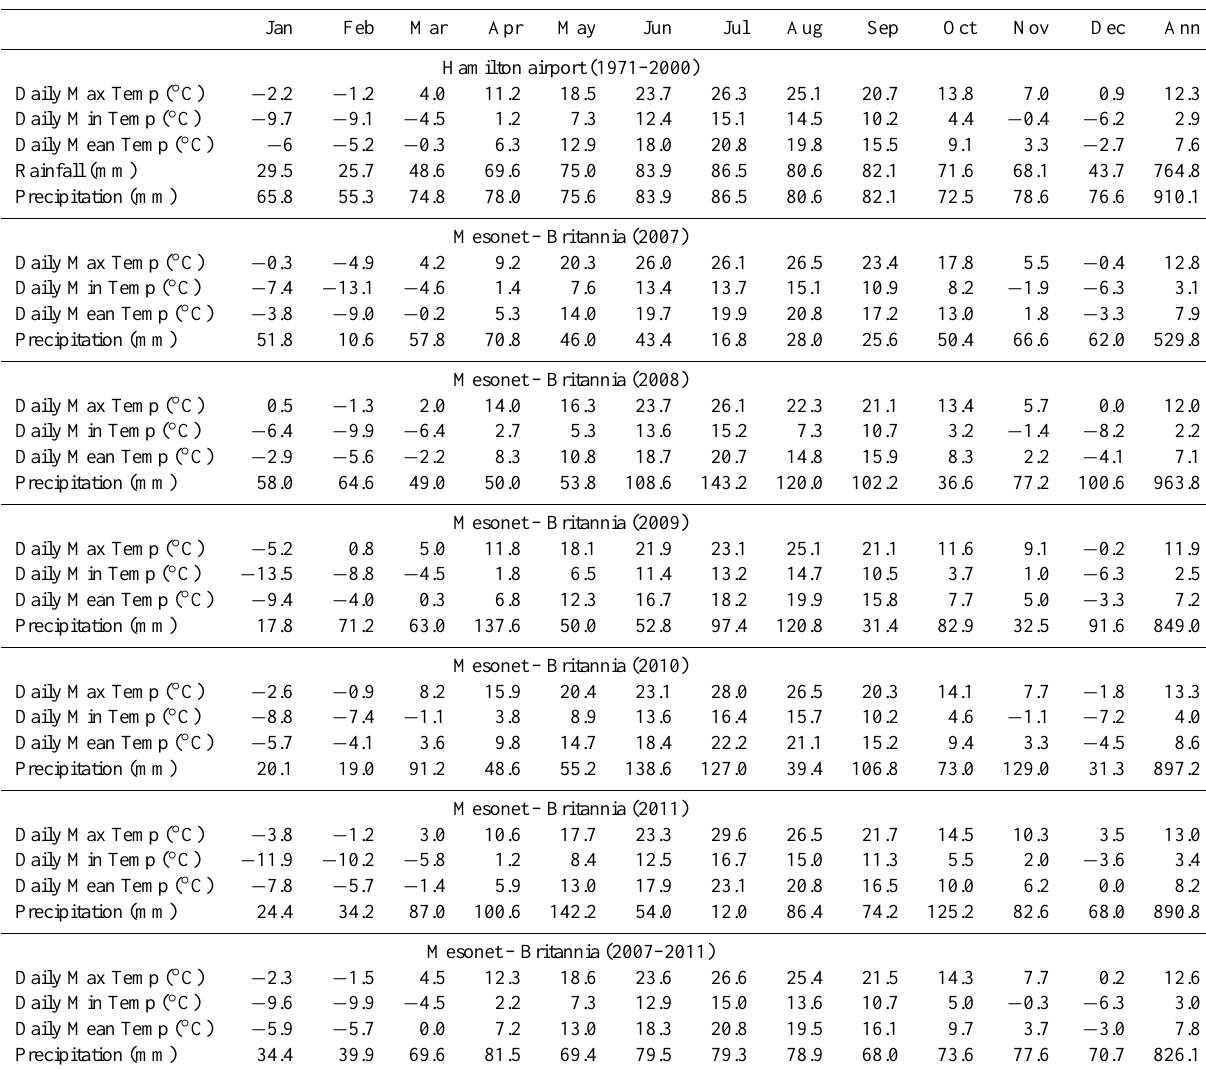
Table 1. Climatic conditions based on Britannia weather station (located at the centre of the watershed) and the Hamilton airport weather station (approx. 5km south of watershed).